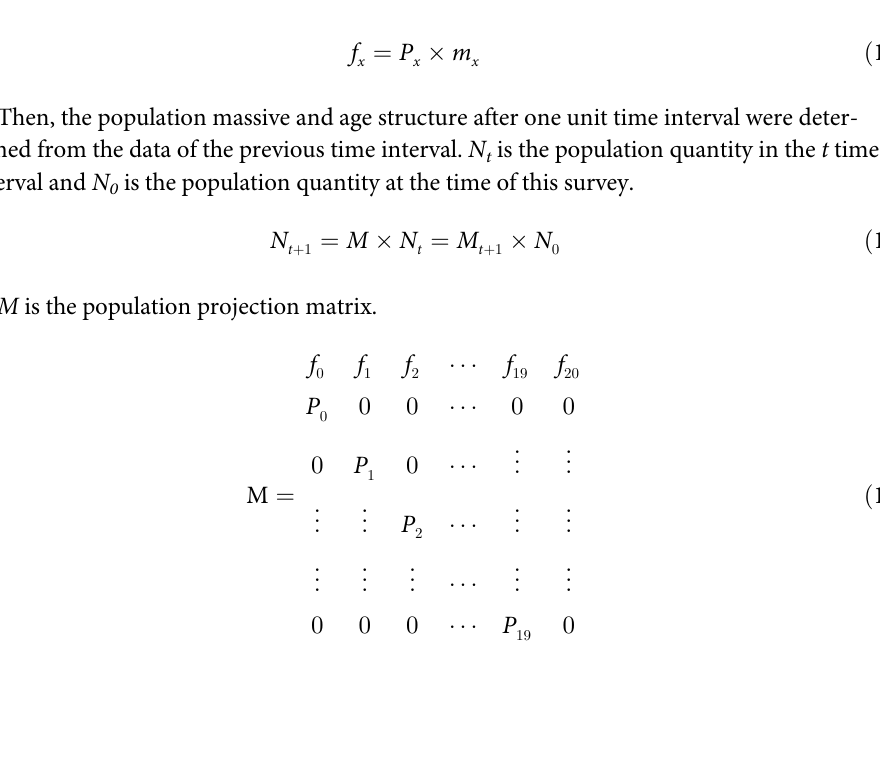
is the population quantity in the t time t